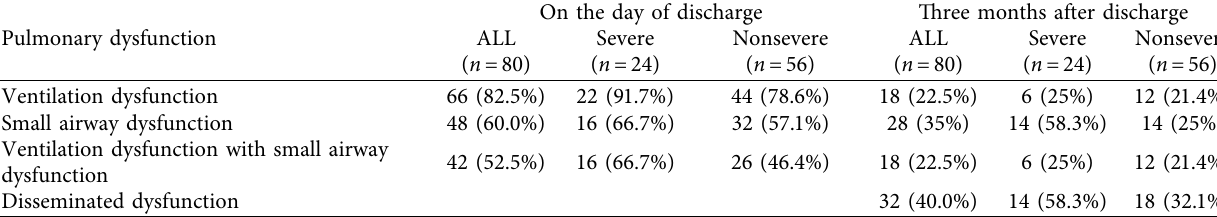
Table 2: Pulmonary function characteristics of COVID-19 patients ( n �